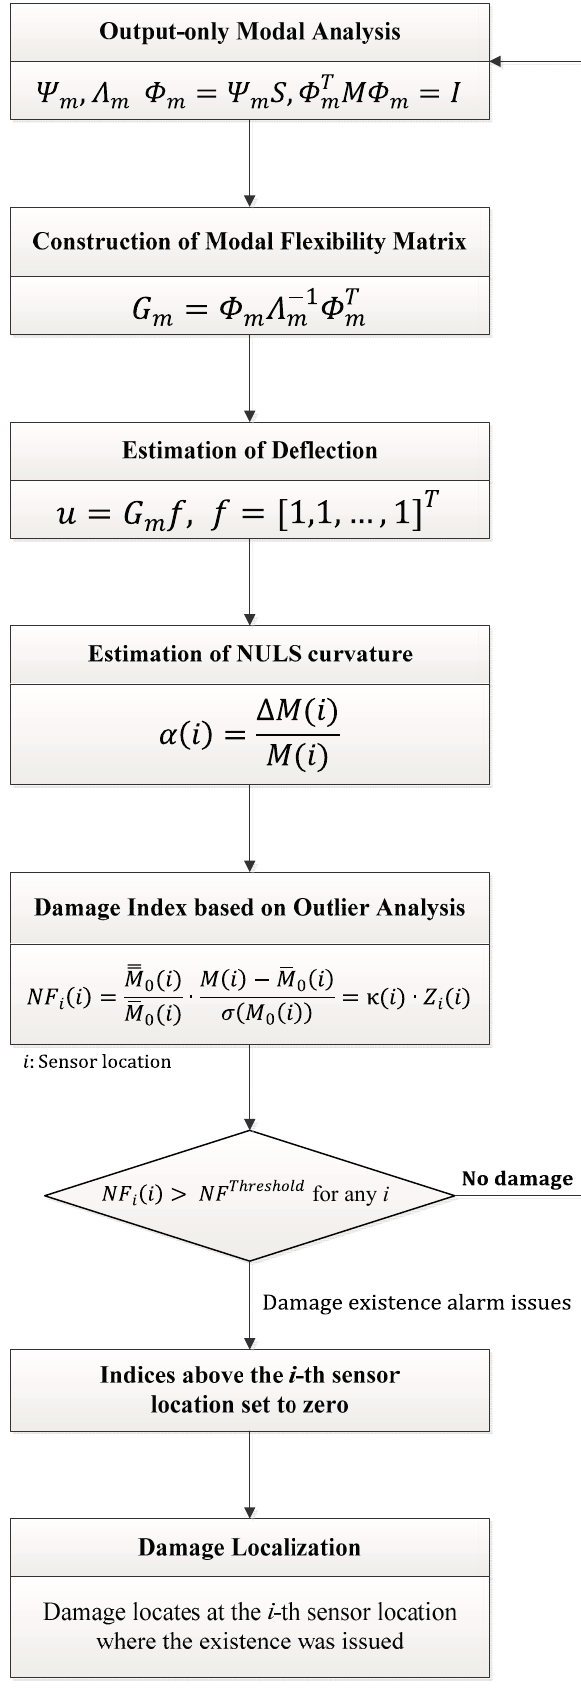
Figure 1. Flow chart of the proposed damage detection